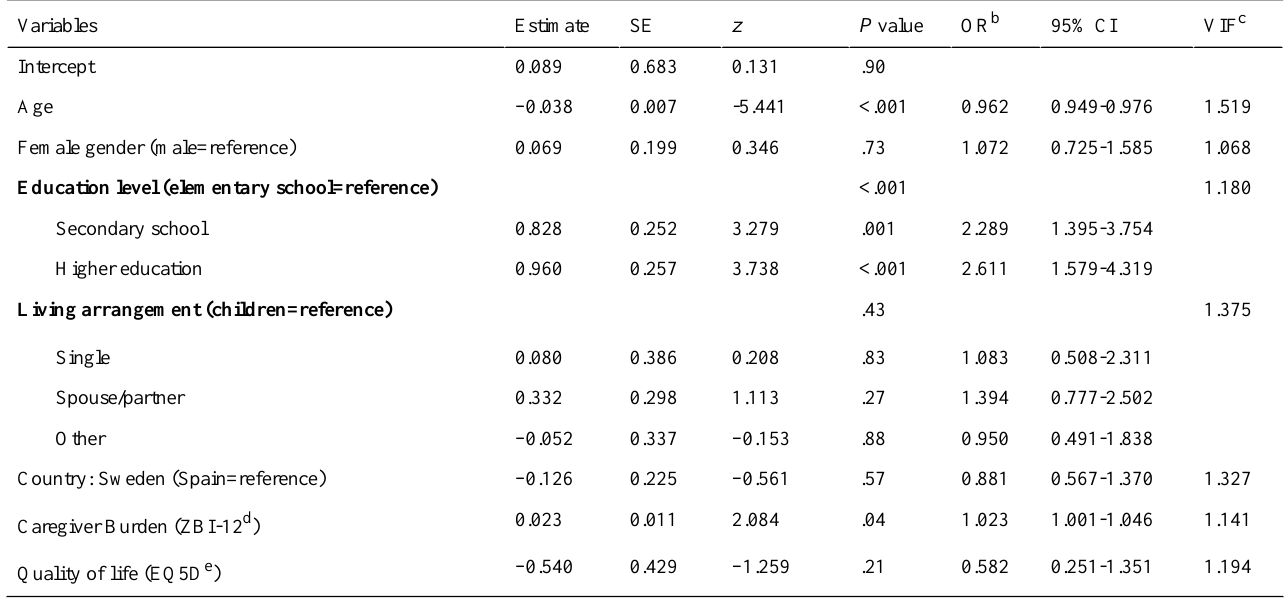
Table 6. Multivariate logistic regression model a of factors associated with use of apps or specific software to support memory in